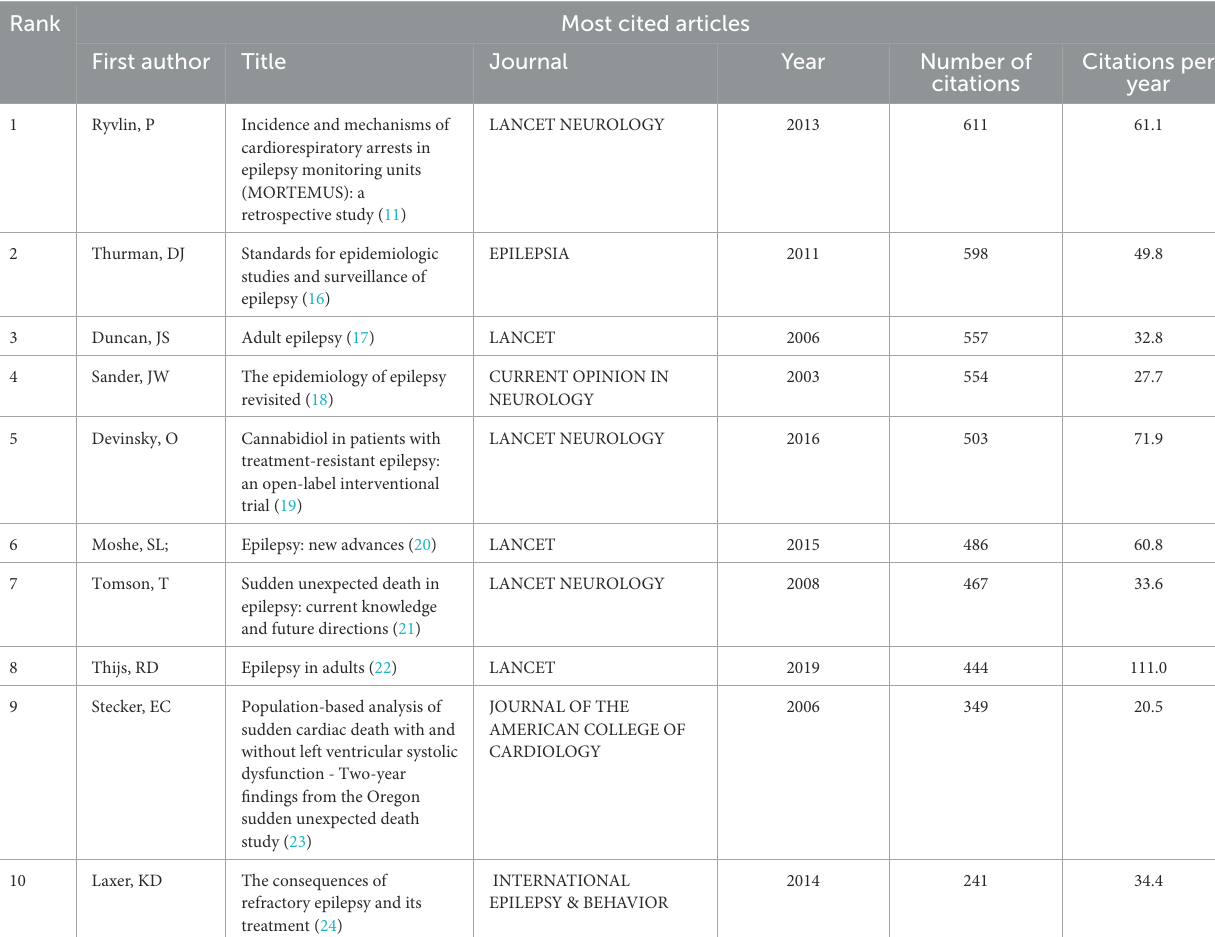
TABLE 5 Top 10 impactful SUDEP